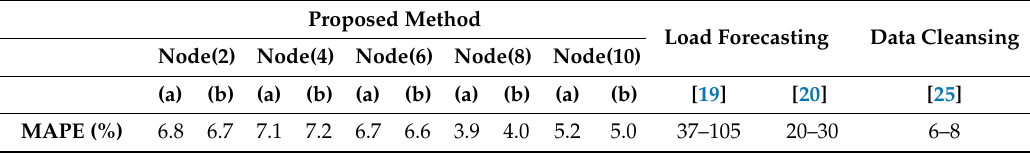
Figure 9. Load data from one building recorded in 2013, Korea.